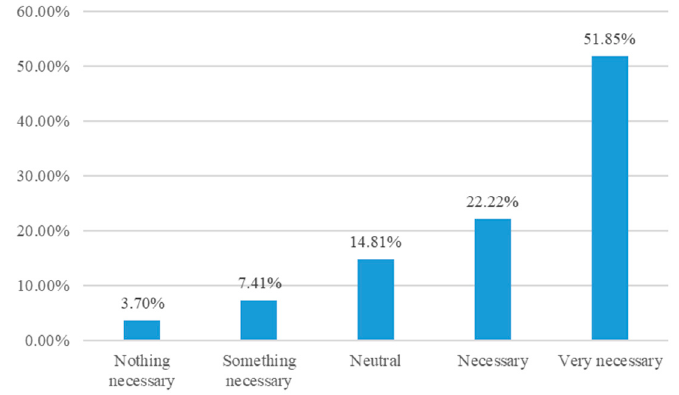
Figure 11. Assessment of whether more funding is needed in HCM.